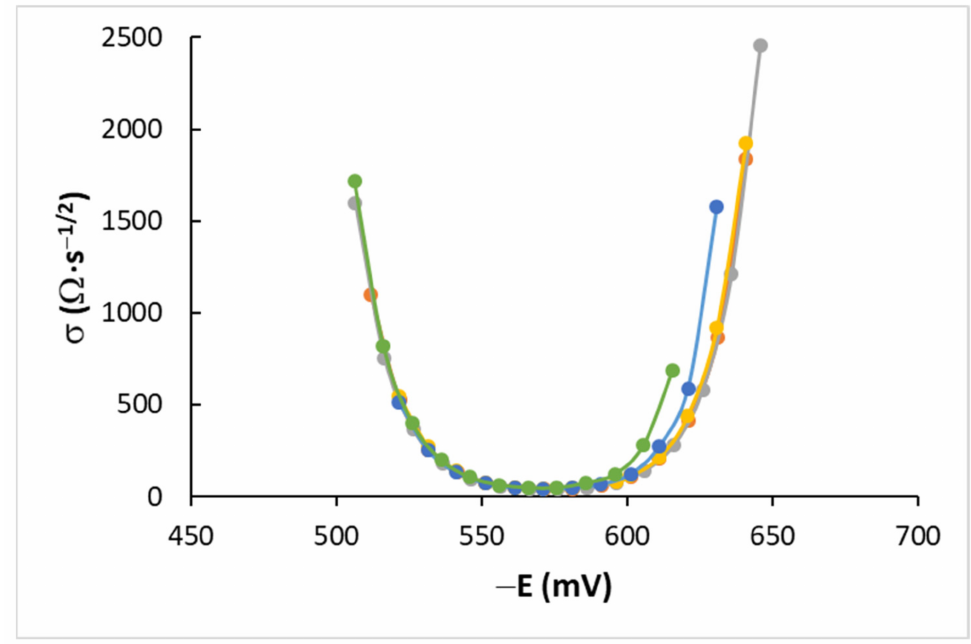
Figure 3. Plot of the Warburg coefficient σ vs. E at different TEA concentrations. TEA concentrations (mM): 0 (orange), 0.75 (grey), 2 (yellow), 5 (blue), 10 (green).